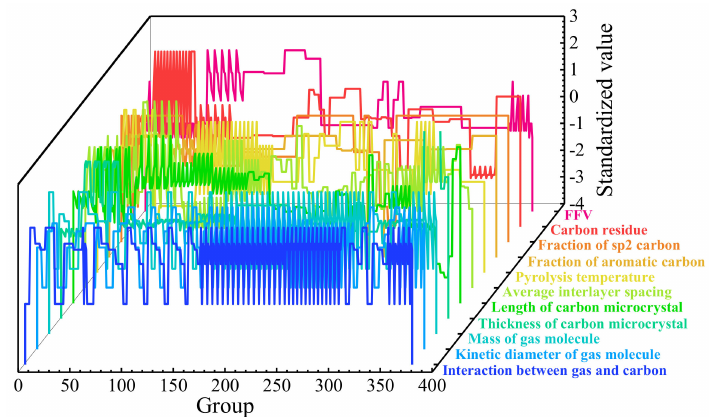
Figure 2. Standardized values of the independent variables.